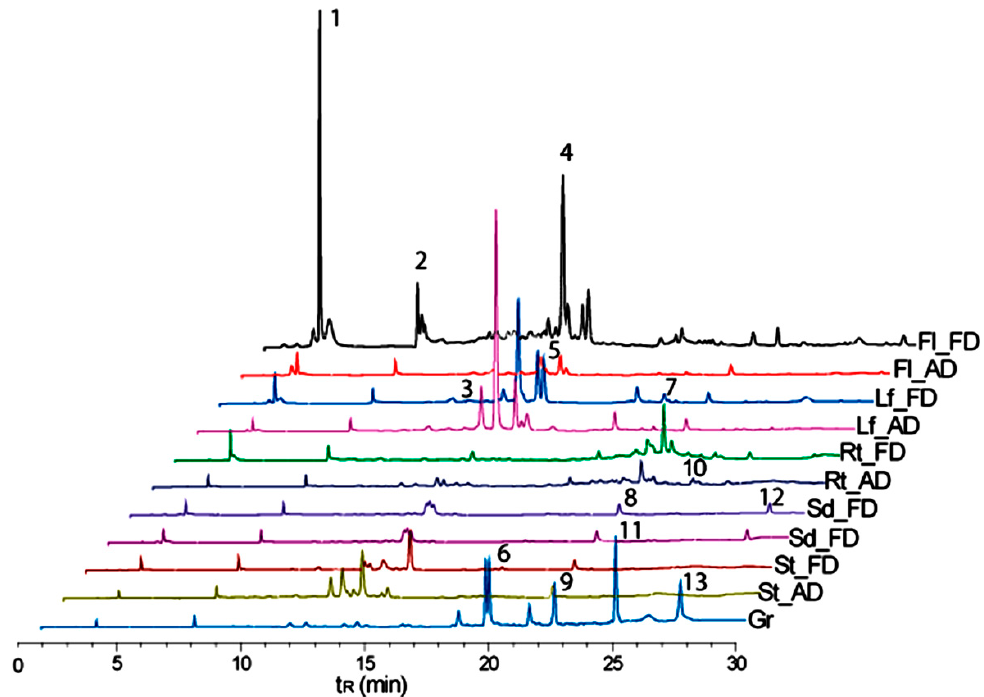
Figure 6. Chromatographic profiles comparing the content of compounds in the extracts from all analyzed plant parts and their respective drying treatment. Methods: AD = air-drying, FD = freeze-drying. Plant parts: Leaves (Lf), stems (St), roots (Rt), seeds (S), flowers (Fl), granules (Gr).